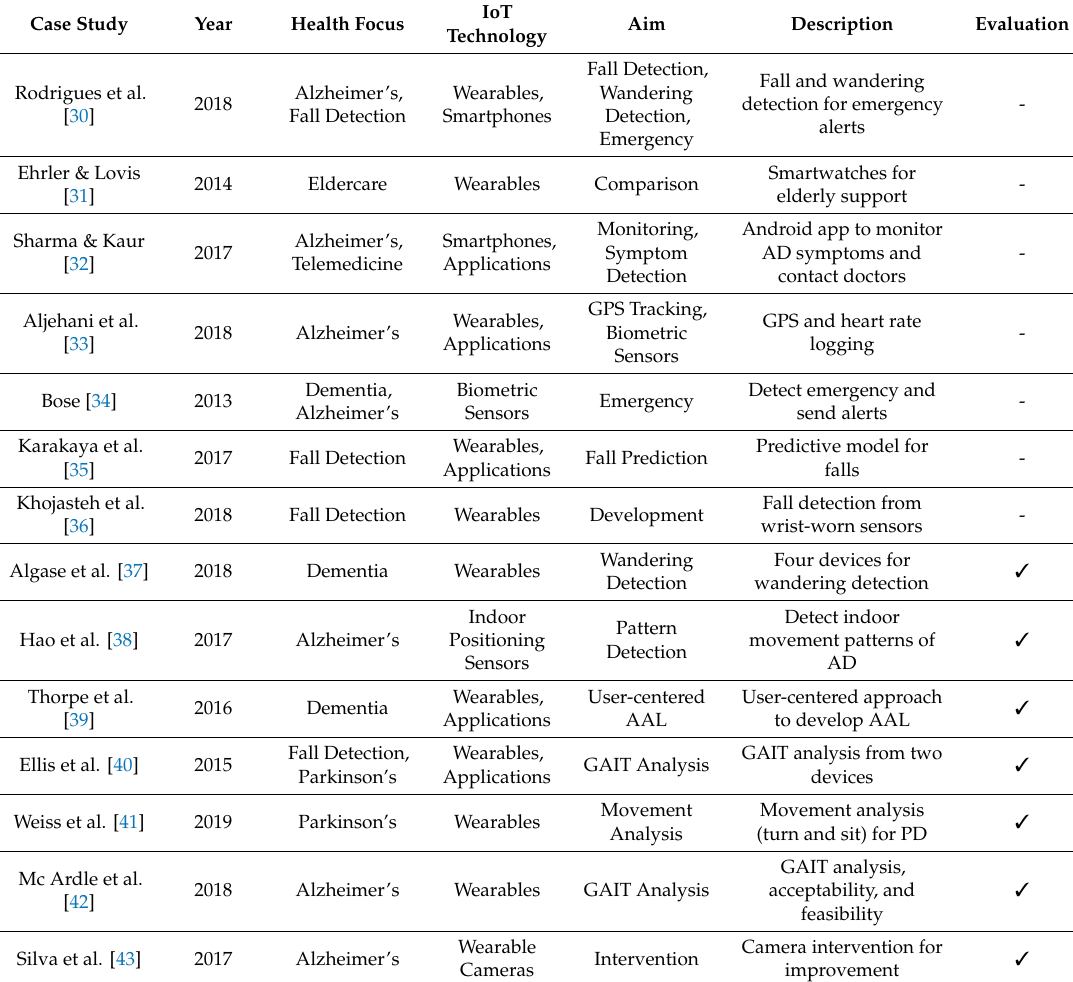
Table 2. Review of case studies and their aspects. AD, Alzheimer’s disease; PD, Parkinson’s disease’ AAL, ambient assisted